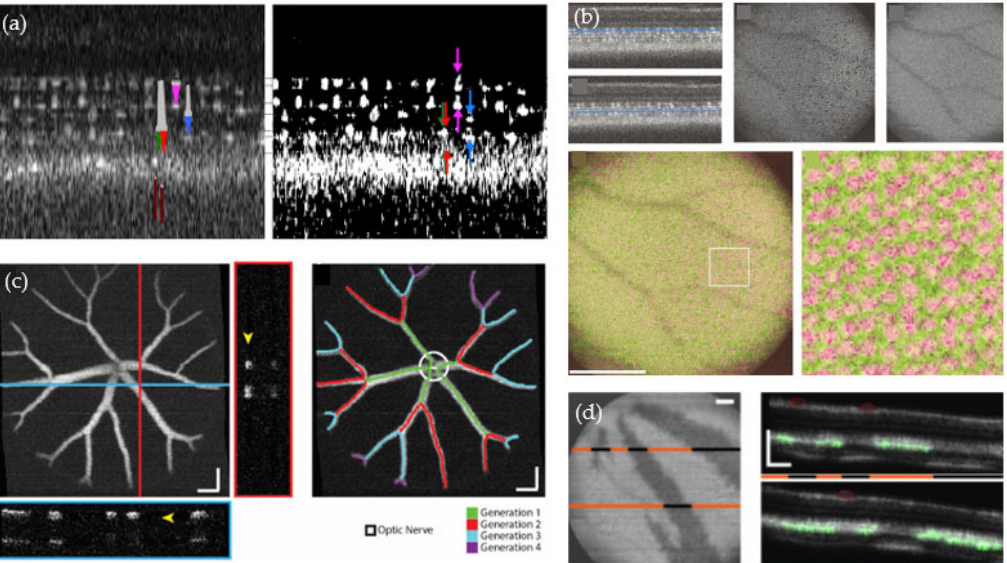
Figure 5. OCT studies conducted in the zebrafish retina. ( a ) High-resolution OCT imaging of the fish eye reveals the microscopic features of the retina [85]. Re-print permission was granted by the Creative Commons Attribution license (CC BY 4.0) by Cambridge University Press. ( b ) The cone mosaic visualized using OCT [86]. Re-print permission was granted by the Creative Commons Attribution license (CC BY 4.0) by Cambridge University Press. ( c ) Quantitative biometry of the zebrafish retinal vasculature. Reprinted with permission from Bozic et al. [73] © The Optical Society. ( d ) Visualizing the melanin distribution in the zebrafish retina using photothermal OCT [71]. Re-print permission was granted under the CC BY-NC-ND license by